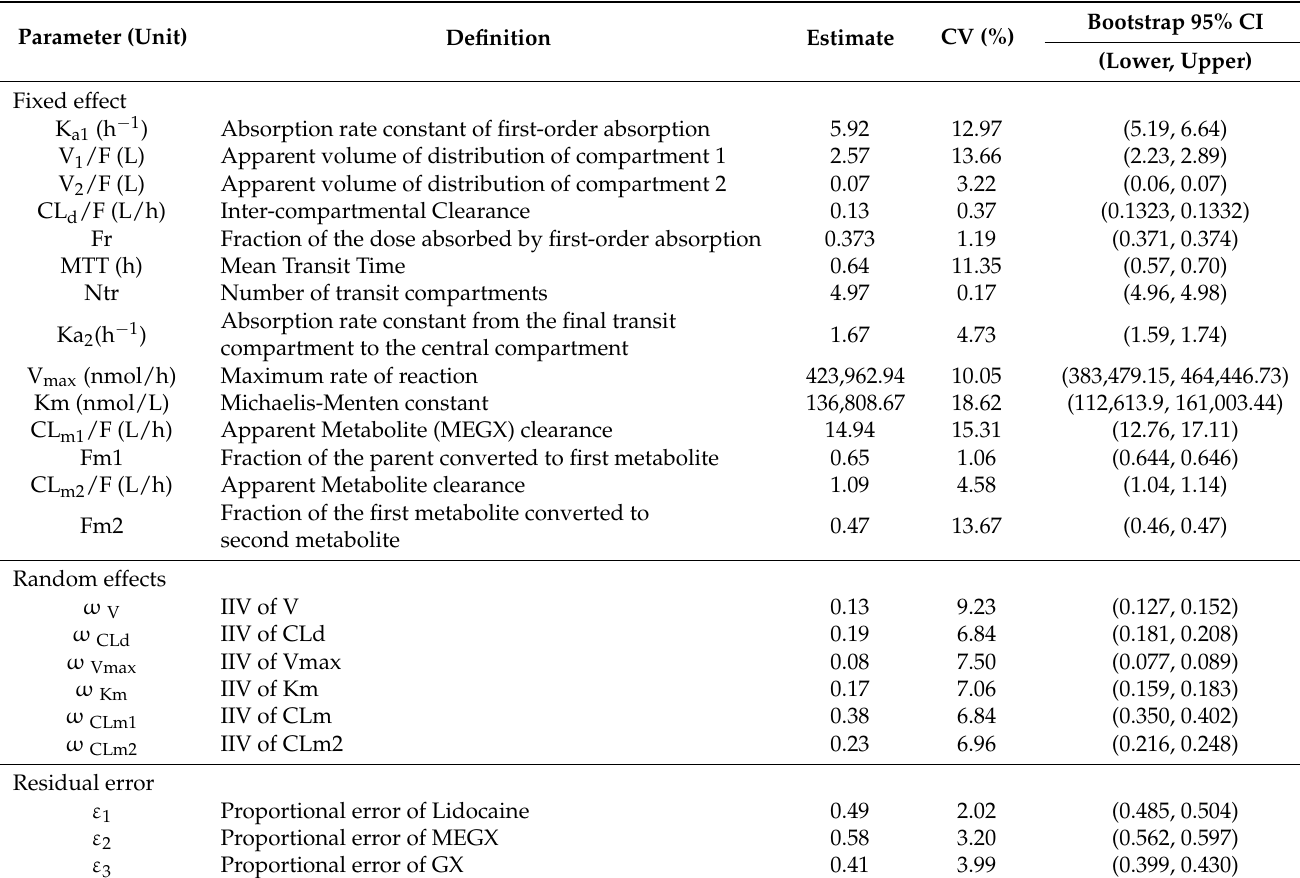
Table 4. Estimated PK parameters of lidocaine, MEGX and GX after LHA administration using non-linear mixed-effect modeling. Parameter (Unit)